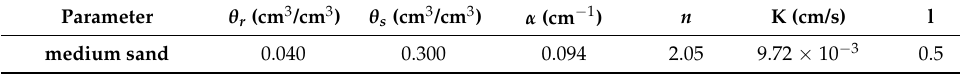
Table 1. Soil hydraulic parameters . Table 2. Soil thermodynamic